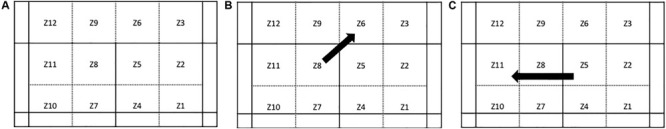
(A) Badminton court divided into 12 identical zones. (B) Example of a diagonal short forward right movement. (C) Example of a transversal large left movement.